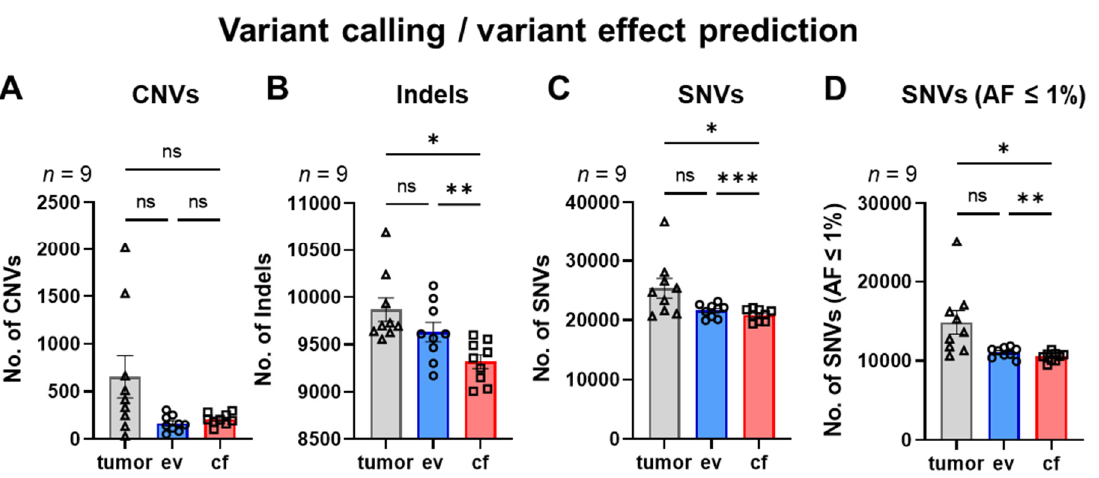
Figure 6. Variant calling/variant effect prediction. ( A ) Number of called CNVs. ( B ) Number of de- tected indels. ( C ) Number of detected SNVs. ( D ) Number of detected SNVs filtered for low allele frequencies (AF ≤ 1%). Statistical tests: ( A – D ) Repeated-measures one-way analysis with Tukey multiple comparisons test; * p < 0.05; ** p < 0.01; *** p < 0.001; ns: no significant difference.